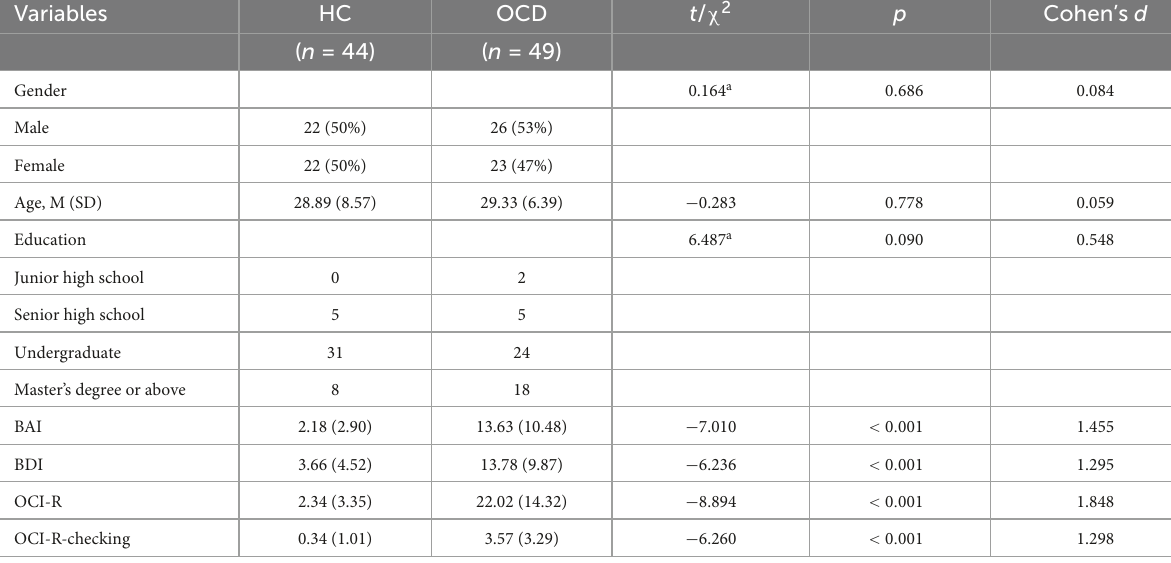
TABLE 1 Demographic characteristics and clinical symptoms of the two groups.